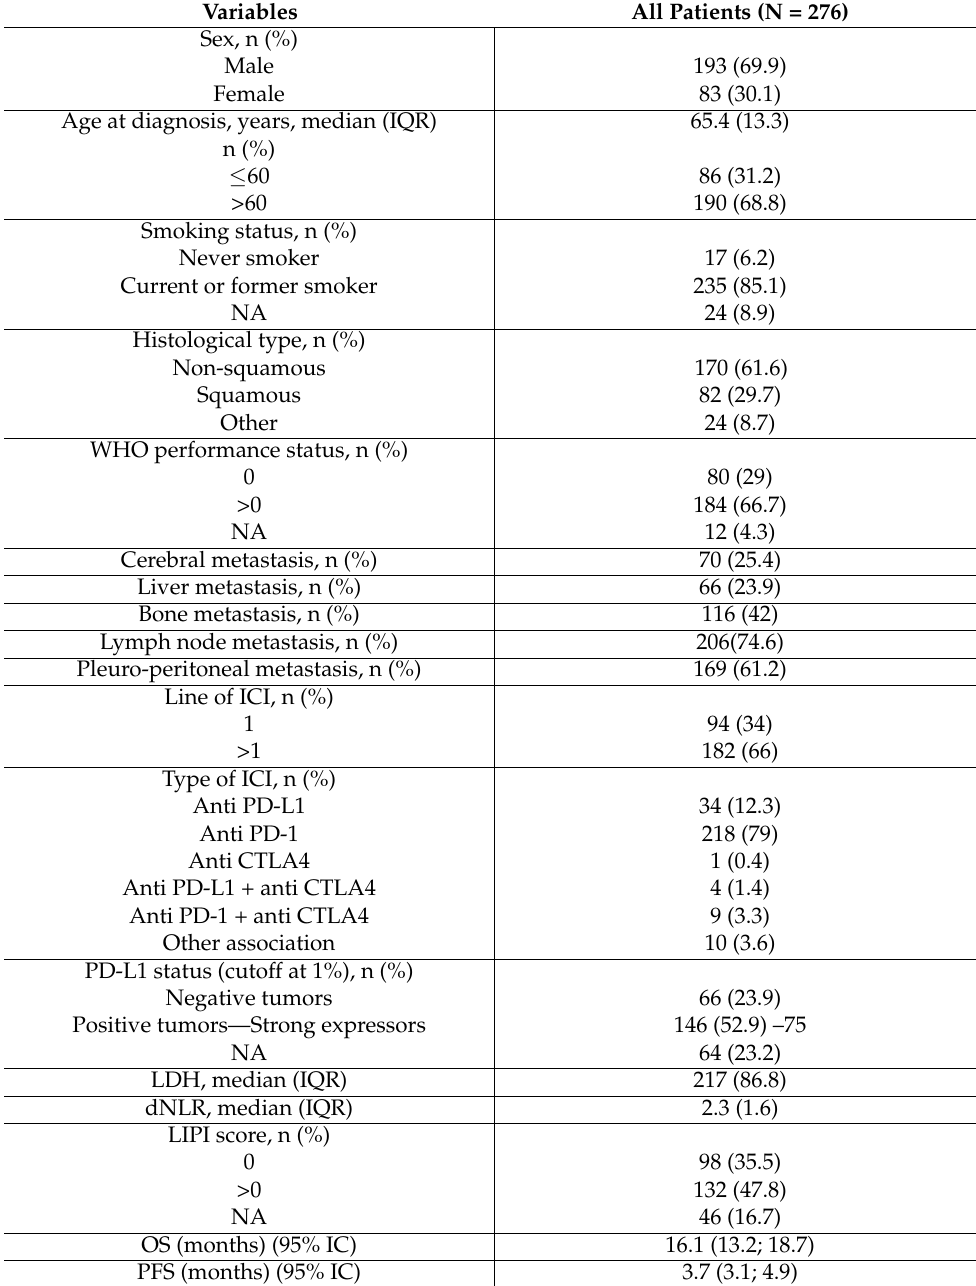
Table 1. Summary of clinical